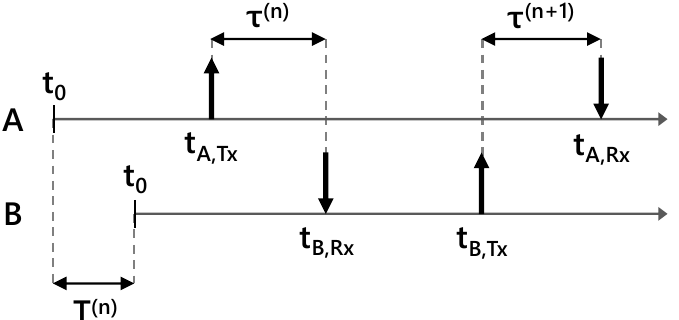
Figure 2. Depiction of two interactions between radios A and B . Interactions are indexed by n . The time offset is labeled T ( · ) and the propagation delay is labeled τ ( · ) . Transmit events are labeled with up arrows, and corresponding receive events are labeled with down arrows. The clocks are ( · ) misaligned, so the receive timestamps t follow Equations (1) and ( · ) , Rx